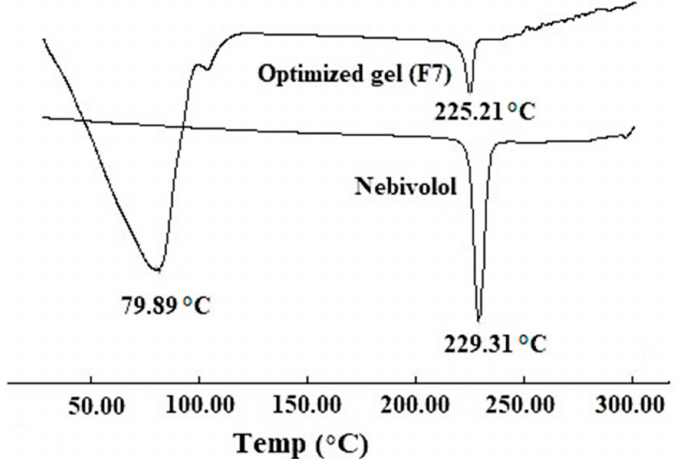
Figure 2. Representative di ff erential scanning calorimetry patterns of nebivolol and optimized gel